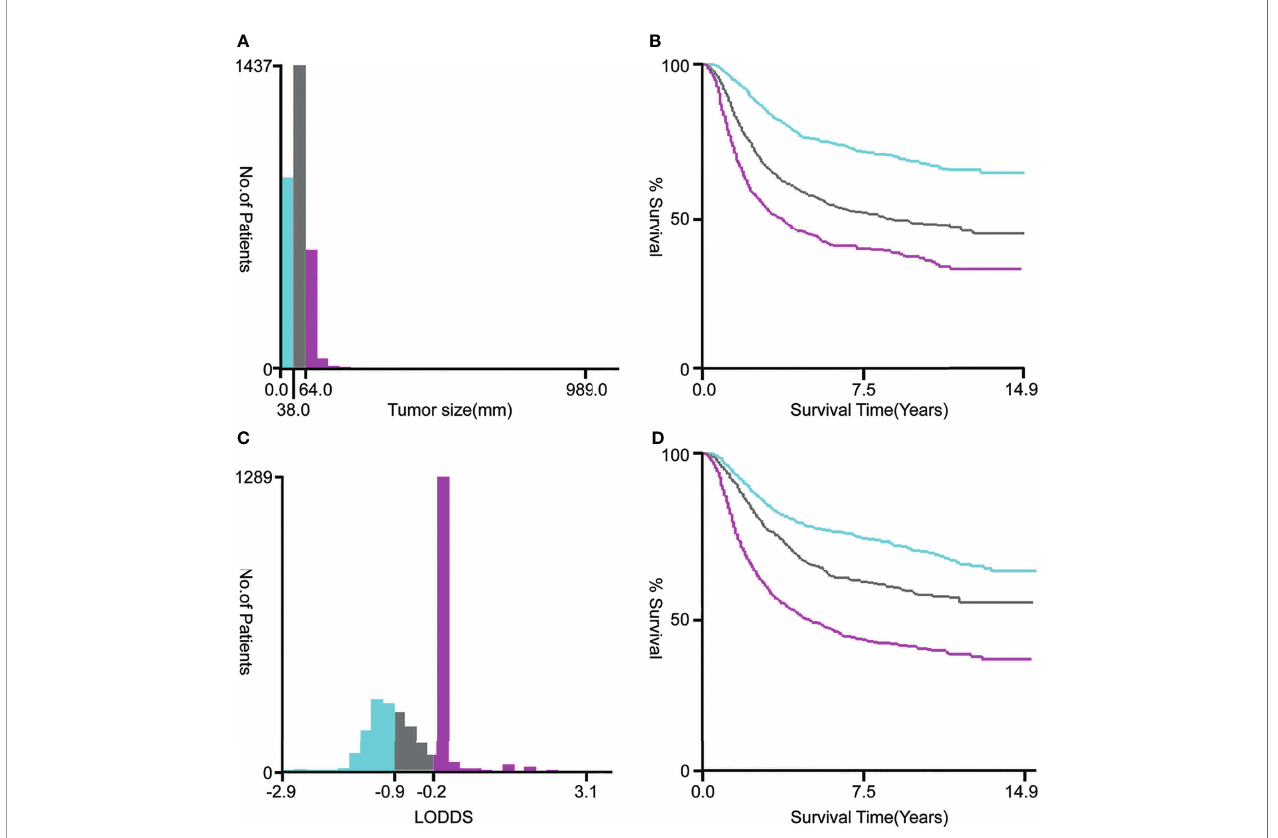
FIGURE 2 | The optimal cutoff values for tumor size (A, B) and LODDS (C, D) via X-tile software analysis. The optimal tumor size cutoff values calculated by overall survival were 38 and 64 mm. The optimal LODDS cutoff values calculated by overall survival were -0.9 and -0.2. Tumor size was divided into ≤ 38 mm (sky blue), 39 – 64 mm (gray), and ≥ 65 mm (pink purple) subgroups. The LODDS was divided into three subgroups: LODDS1 (LODDS ≤ -0.9, sky blue), LODDS2 (-0.9 < LODDS ≤ -0.2, gray), and LODDS3 (LODDS > -0.2, pink purple). LODDS, log odds of positive lymph